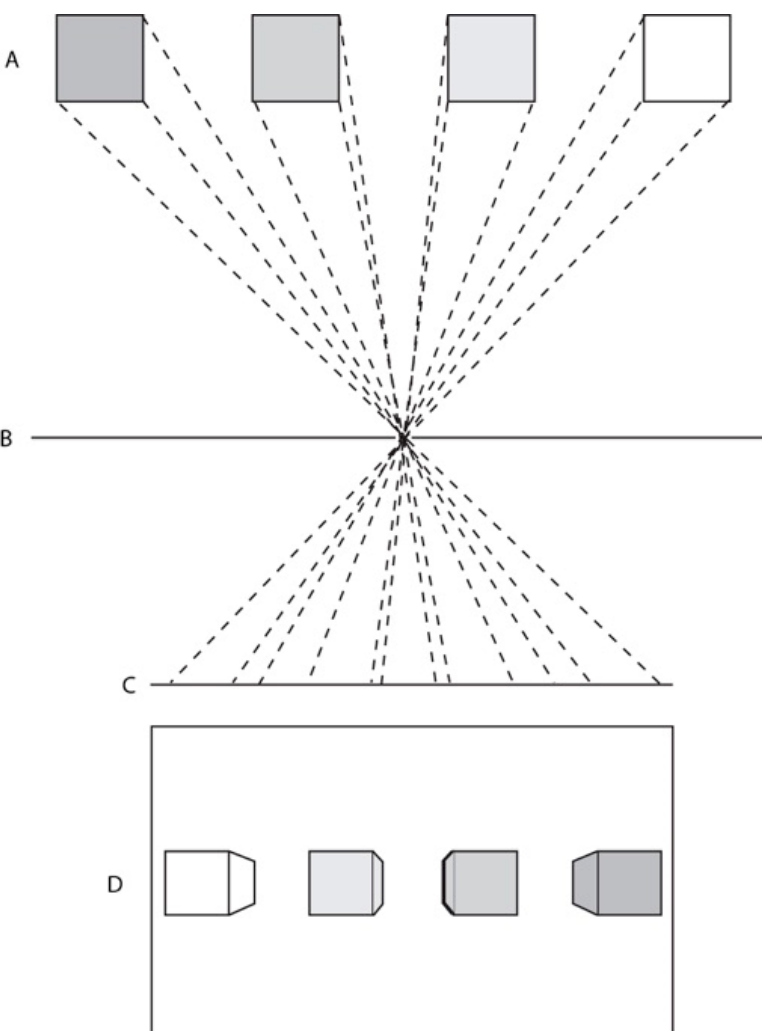
Figure 1. ( A ) schematic diagram of the geometrical principle of linear perspective. Four cubes are shown at ( A ) in plan-view; At ( B ) is shown a light barrier with a centrally located pinhole; ( C ) shows a plane on which the light rays, a subset of which are indicated by dashed lines, travelling from the cubes at A are projected; ( D ) shows an elevation view of the scene as rendered from the projection.